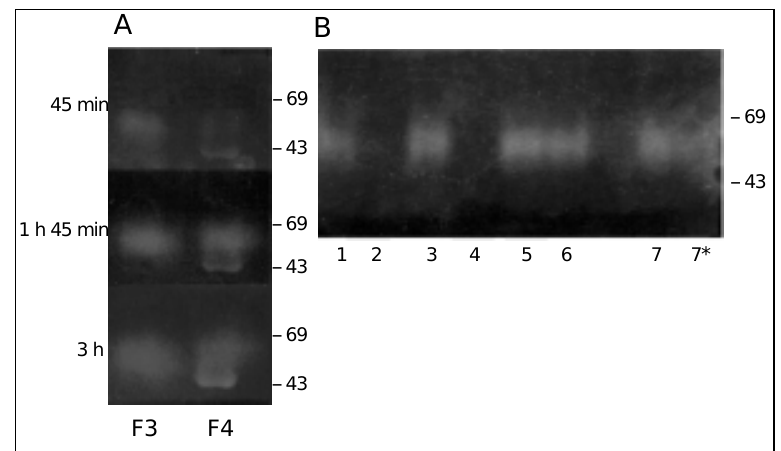
Figure 1 - Demonstration of P. brasiliensis exocellular proteolytic activity in SDS-PAGE gels using Abz-MKALTLQ-EDDnp in agarose overlays, and enzyme characterization with pro- tease inhibitors. A , The hydrolytic activity in F3 (1.25 µg) and F4 (5.0 µg) was recorded after 45 min, 1 h and 45 min, and 3 h of incubation at 37 o C. Fluorescence of the 43-kDa component was intrinsic, and was observed without the peptide overlay. B , F3 (1.25 µg) alone (lane 1), or inactivated by boiling (lane 2), pre-incubated with 2.5 mM ortho -phenan-